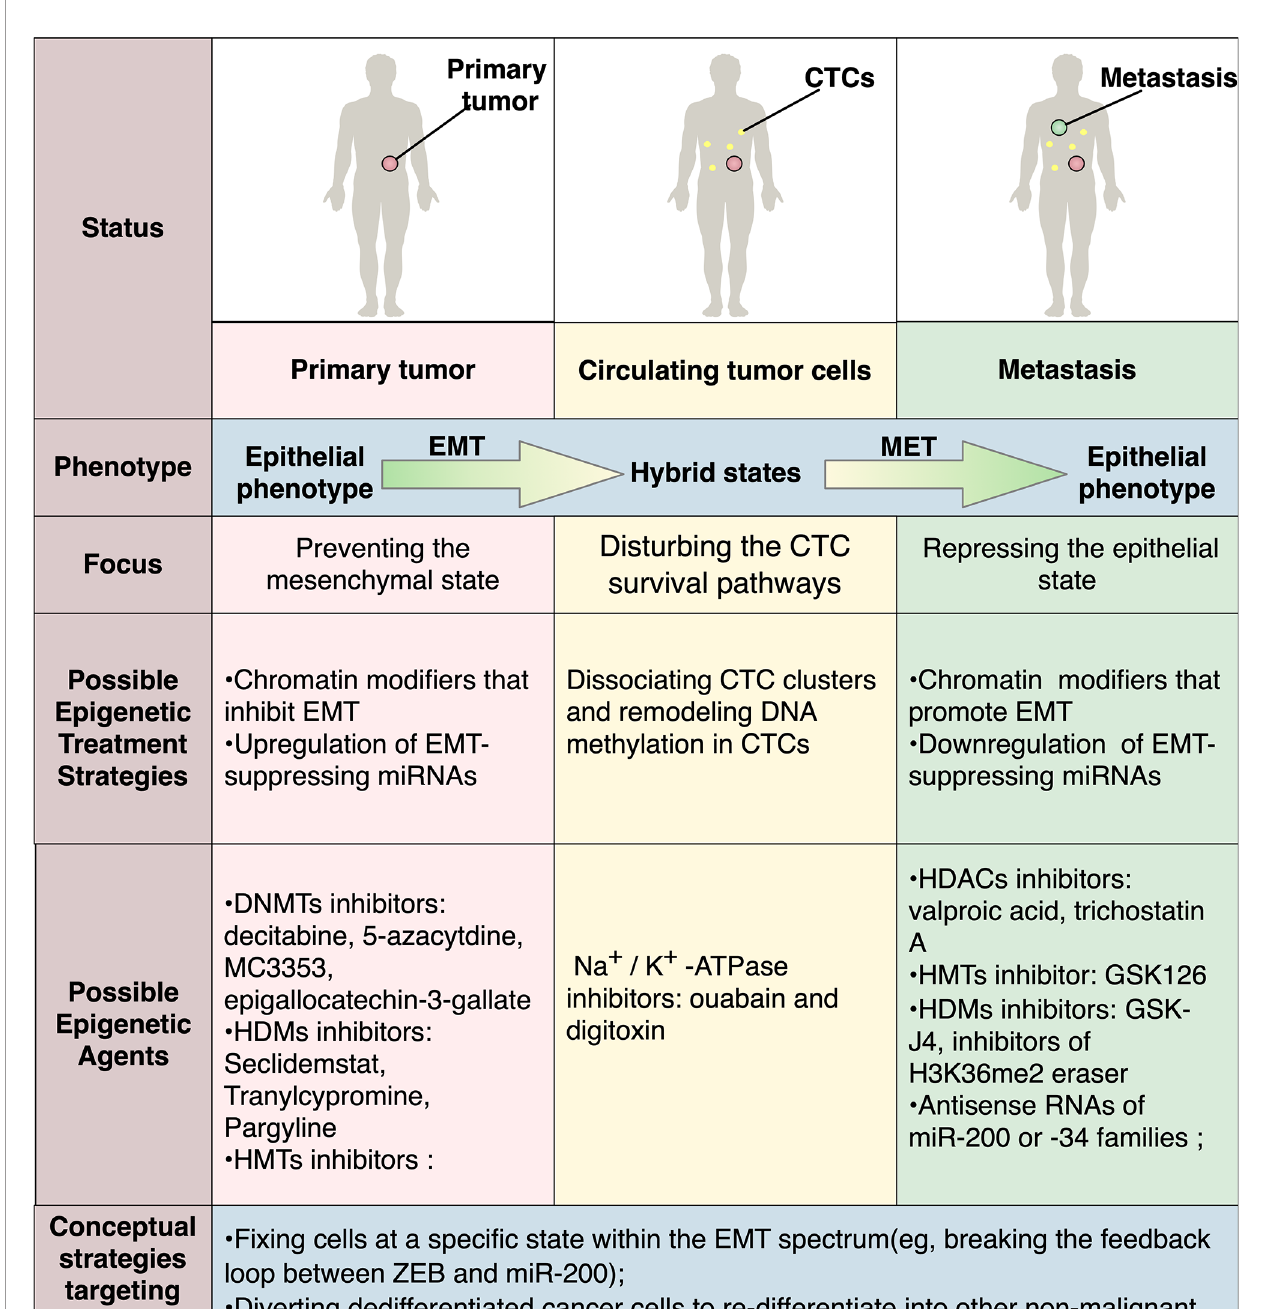
FIGURE 4 | Possible therapeutic strategies targeting EMT plasticity via epigenetic modi fi cation. In different stages of metastasis, EMT and MET play contradictory roles, highlighting the need for context-speci fi c therapeutic modalities for distinct disease status. As the interactions between EMT-TFs and epigenetic regulators have been widely revealed, targeting epigenetic mechanisms to manipulate EMT will have a promising therapeutic potential. Possible strategies include manipulation of miR-200s or miR-34 or chromatin modi fi ers that modulate EMT-TFs. Recently, treatments targeting CTCs are also emerging as exempli fi ed by ouabain and digitoxin, which are FDA-approved Na + /K + -ATPase inhibitors and are identi fi ed to dissociate CTC clusters that harbor distinct DNA methylation pattern. Besides, various conceptual strategies targeting EMT plasticity are also proposed, with some of them are already proved effective in preclinical